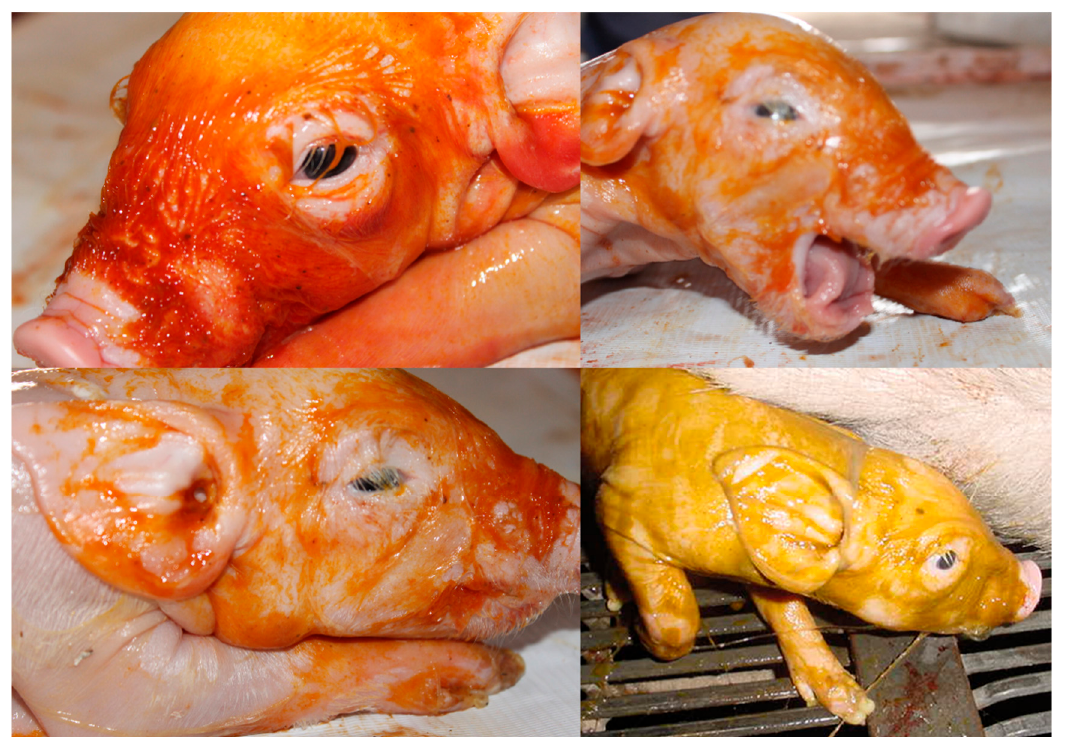
Figure 3. Neonatal piglets with perinatal hypoxia syndrome. When the neonate goes through a severe hypoxia process, it displays bradycardia, yellow to greenish meconium staining, tachypnea, lactic acidemia, hypothermia, hypoglycemia, adynamia, and flaccid muscle tone. Neonates with this perinatal syndrome do not recover, since they do not connect with the teat and are sluggish, which is why they die in the following postpartum hours. There is no neonatal intensive therapy area on pig farms.